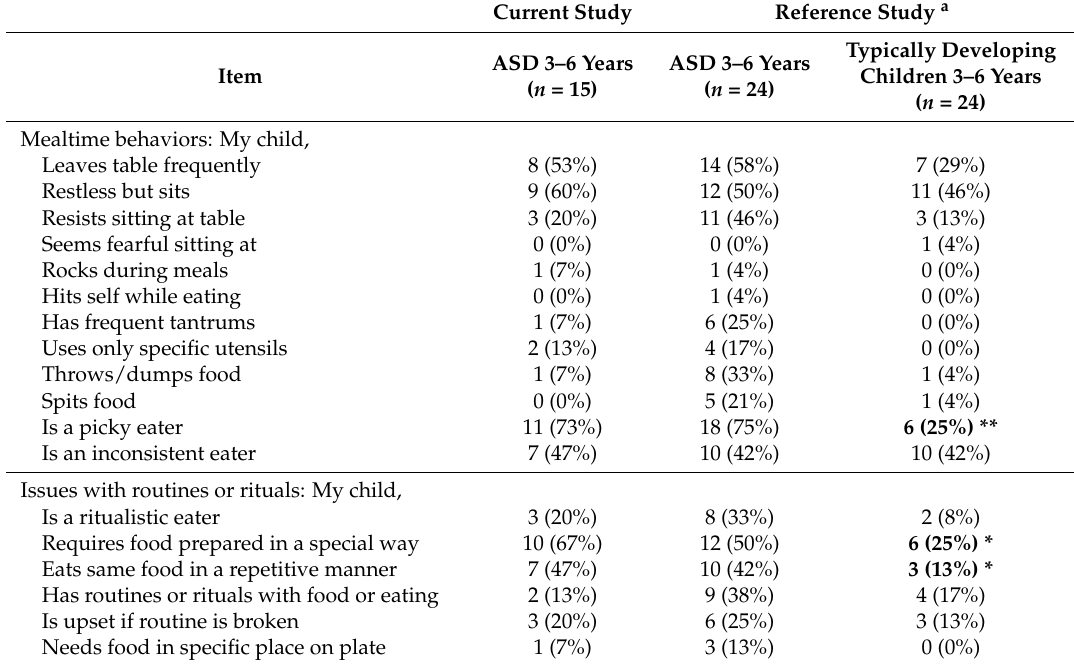
Table 6. Parental views on mealtime behaviors, issues with routines or rituals, and eating